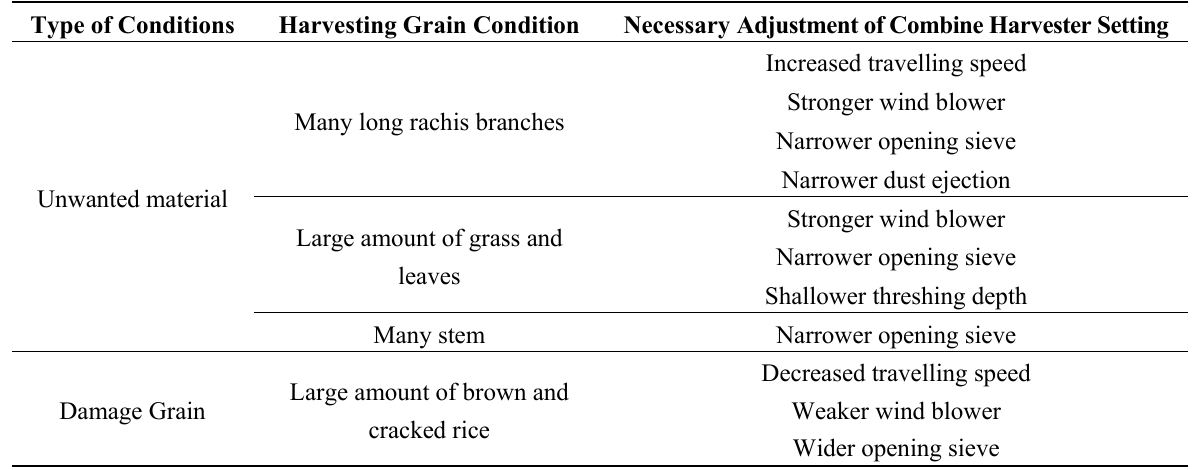
Table 1. Harvesting grain conditions and necessary adjustment of the combine harvester